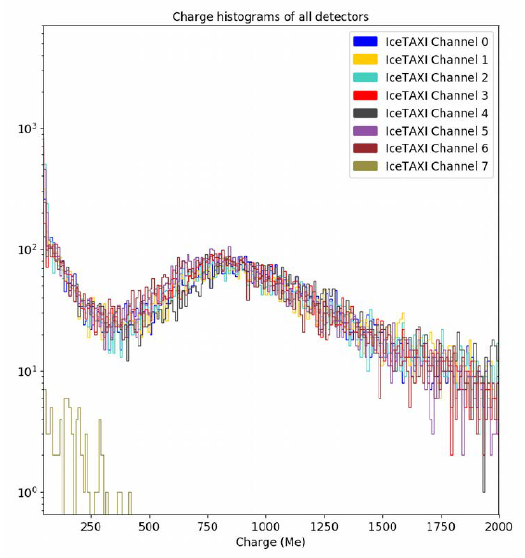
Figure 4. Distribution of MIP particles of seven detectors at the South Pole. Channel 7 of the IceTAXI readout system is not equipped with a detector, i.e. intrinisc noise of the TAXI board is recorded, only.